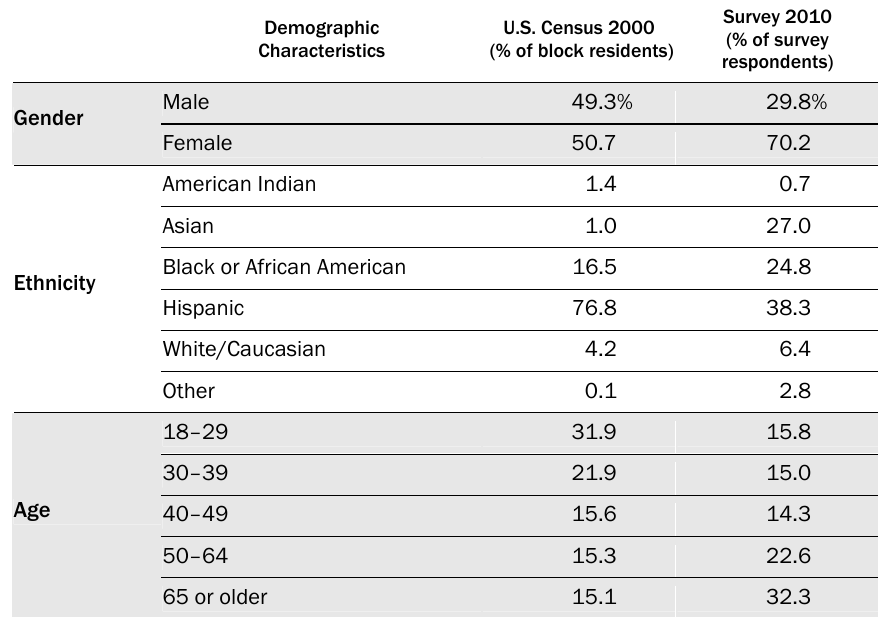
Table 2: Gender, Ethnicity and Age Profile of Survey Participants (N=149) Compared With the 2000 U.S. Census of Blocks Demographic